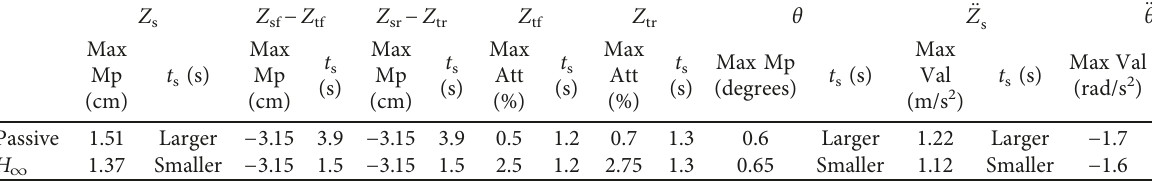
Table 2: Time domain contrasting for passive and fuzzy-H